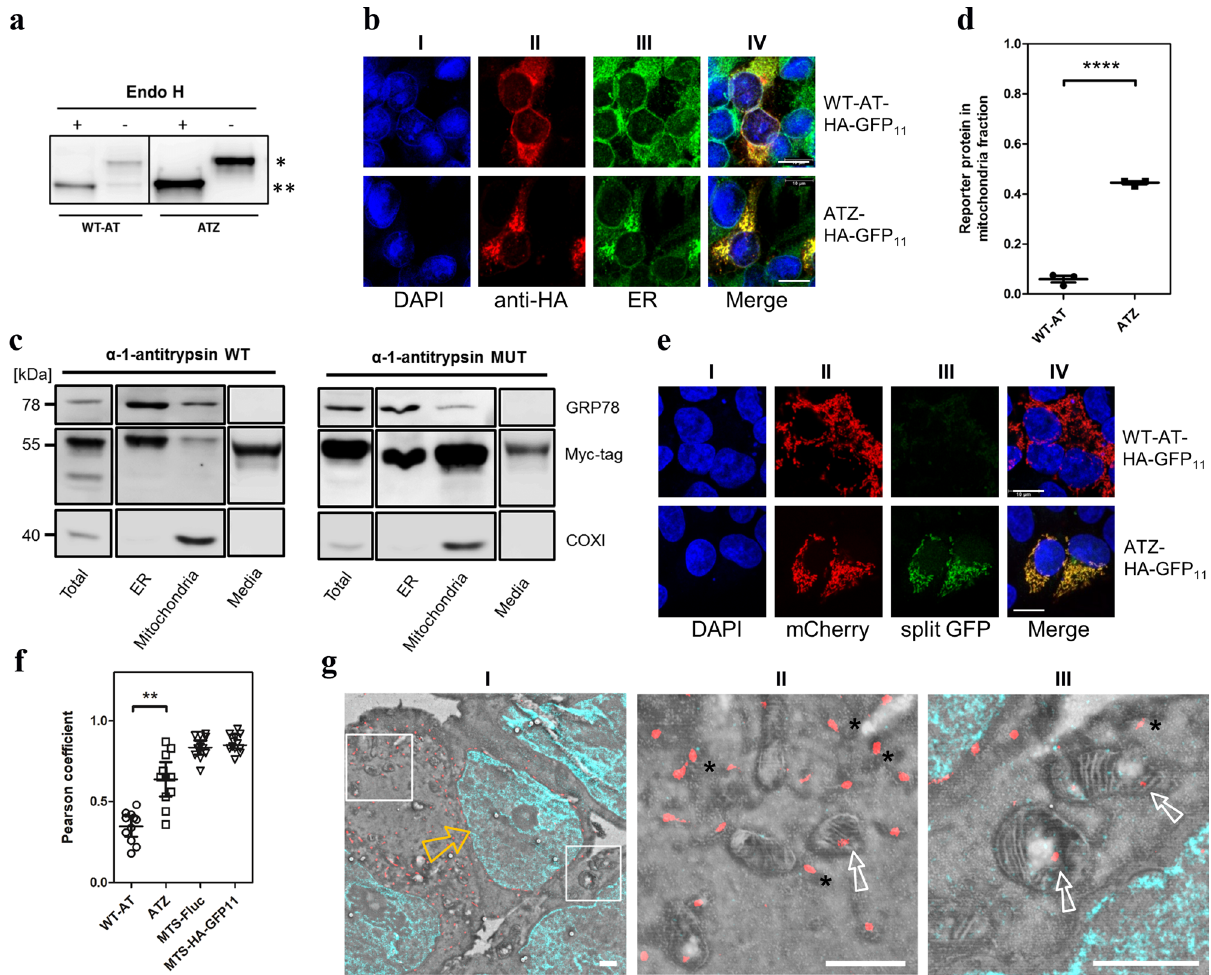
Fig. 4 Mitochondrial localization of mutant α 1-antitrypsin. a Representative Western blot of α -1-antitrypsin-WT (WT-AT) and α -1-antitrypsin mutant (ATZ) samples treated with endoglycosidase H. * = untreated, glycosylated WT-AT and ATZ. ** = upon treatment with Endo H, α -1-antitrypsin is found in its non-glycosylated form for both WT-AT and ATZ. b Confocal microscopy image of HEK293 cells expressing WT-AT and ATZ to demonstrate ER localisation. I – DAPI, blue; II – anti-HA-tag, red; III – anti-calreticulin (ER-marker), green; IV – overlay I), II), and III), co-localized signal yellow.